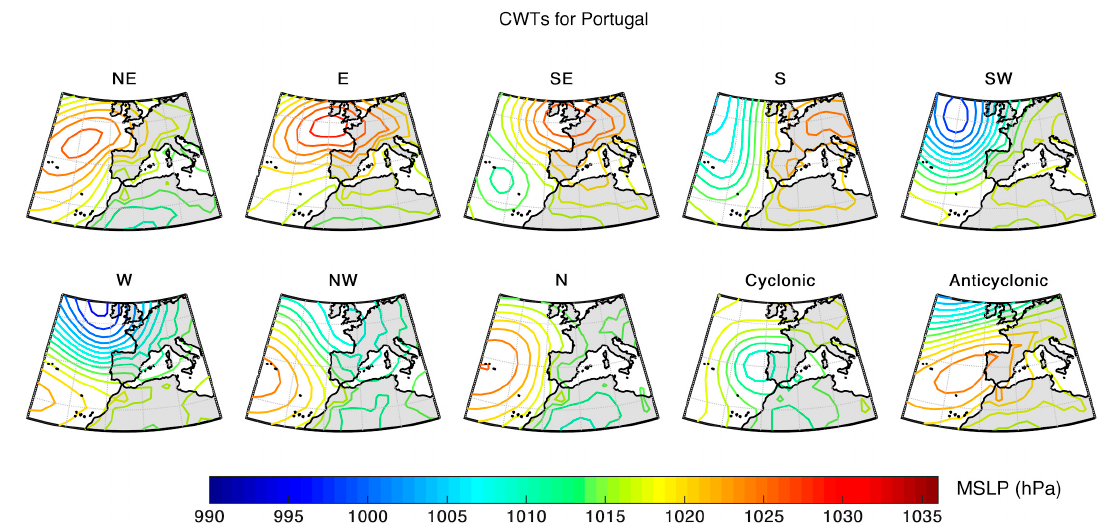
Figure 2. Average mean sea level pressure for each circulation weather type (CWT), centered over mainland Portugal during 2006–2018.